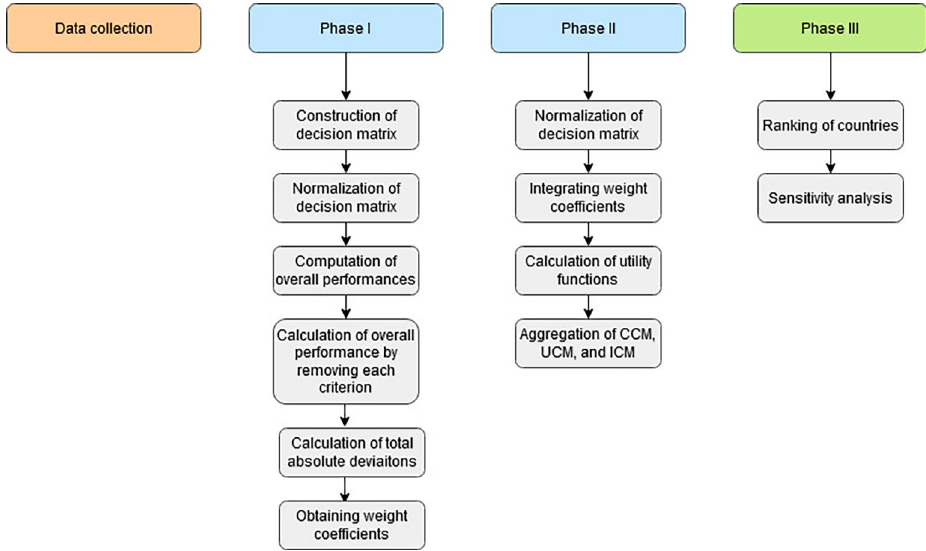
Figure 1. The procedure of the introduced MEREC-DNMA